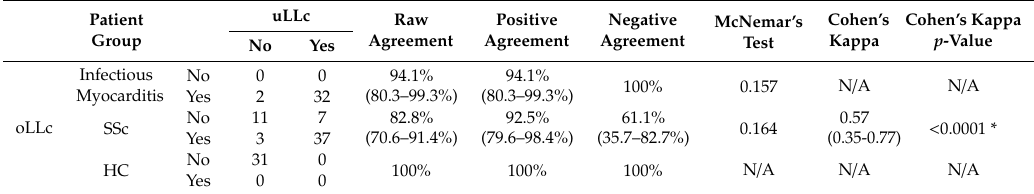
Table 3. Cross-tabulations and inter-method agreement and marginal homogeneity testing between the original and updated Lake Louise criteria, denoting the presence / absence of myocarditis or myocardial inflammation (no / yes). The criteria are presented in detail in Table 1. Positive and negative agreement refer to the respective category of the oLLc. In cases where there was perfect agreement, confidence intervals for percentage agreement and some agreement statistics cannot be calculated.